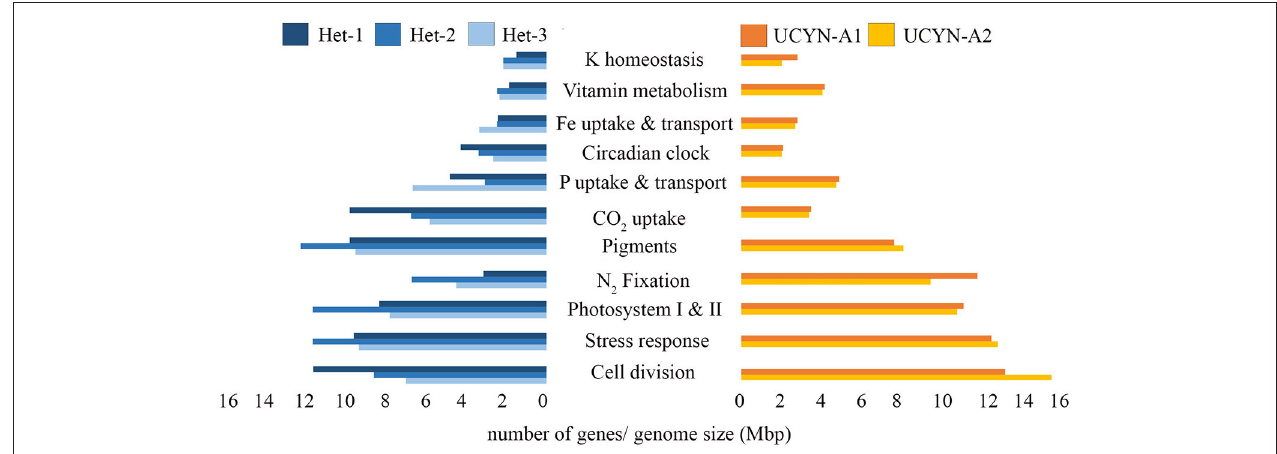
FIGURE 1 | Subsystem (genes with similar function) comparison between DDA and UCYN-A symbionts. Each bar indicates the number of genes in a particular subsystem normalized against genome size (Mbp